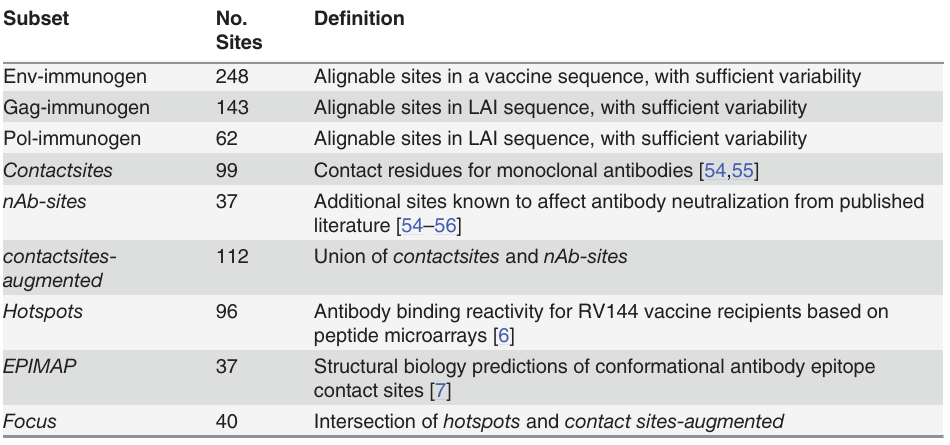
were alignable, suf fi ciently variable, and that corresponded to a vaccine immunogen sequence